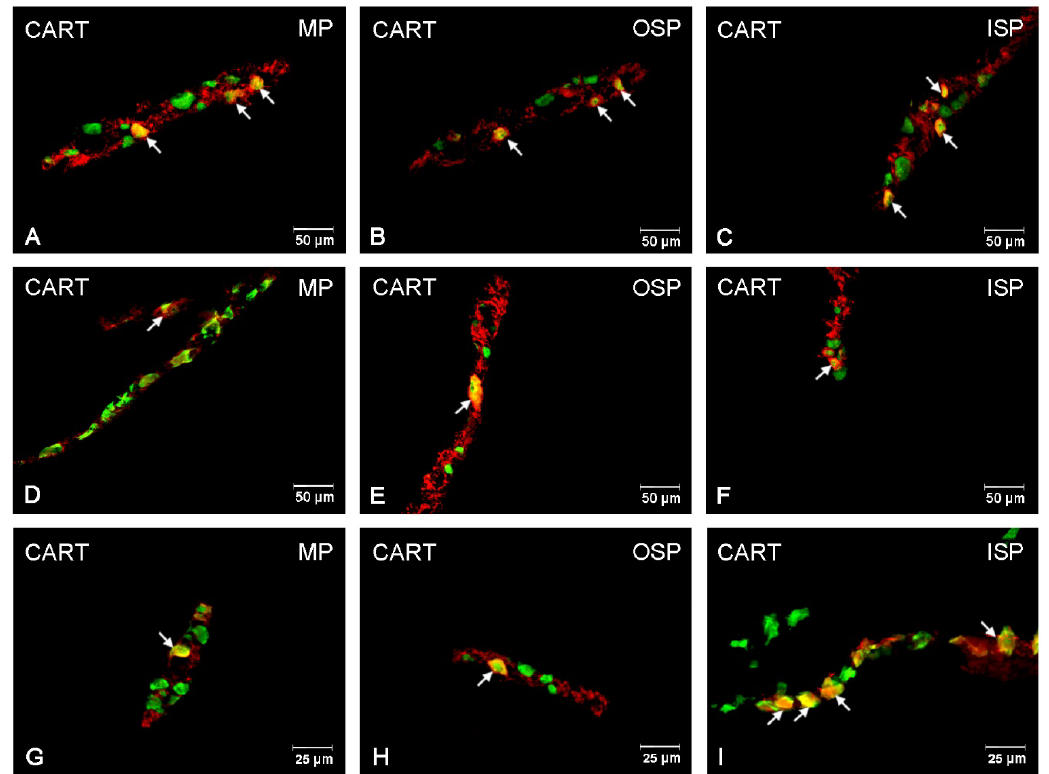
Figure 1. Bar graph showing the percentage variation in the number of cocaine- and amphetamine- regulated transcript (CART)—immunoreactive neurons as a result of low (black bar) and high (blue bar) dose of acrylamide supplementation in the porcine jejunum enteric plexuses. Control pigs (grey bar), MP—the myenteric plexus; OSP—the outer submucosal plexus; ISP—the inner submucosal plexus. * p < 0.05, ** p < 0.01,*** p < 0.001 point to differences in the expression of exact substance studied with reference to the control pigs.